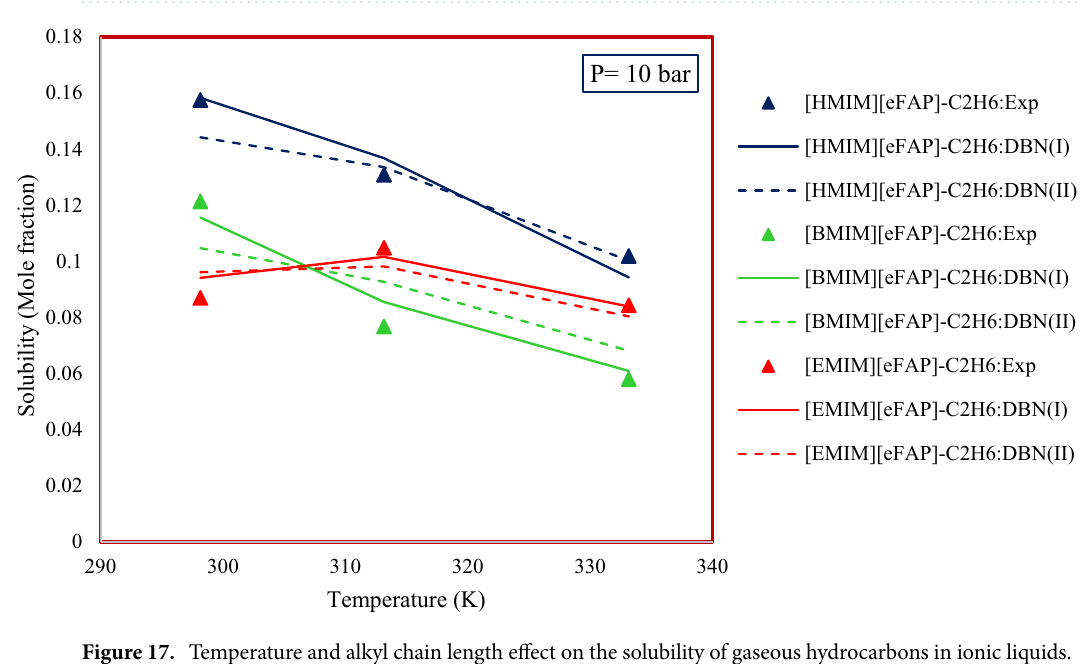
Figure 17. Temperature and alkyl chain length effect on the solubility of gaseous hydrocarbons in ionic